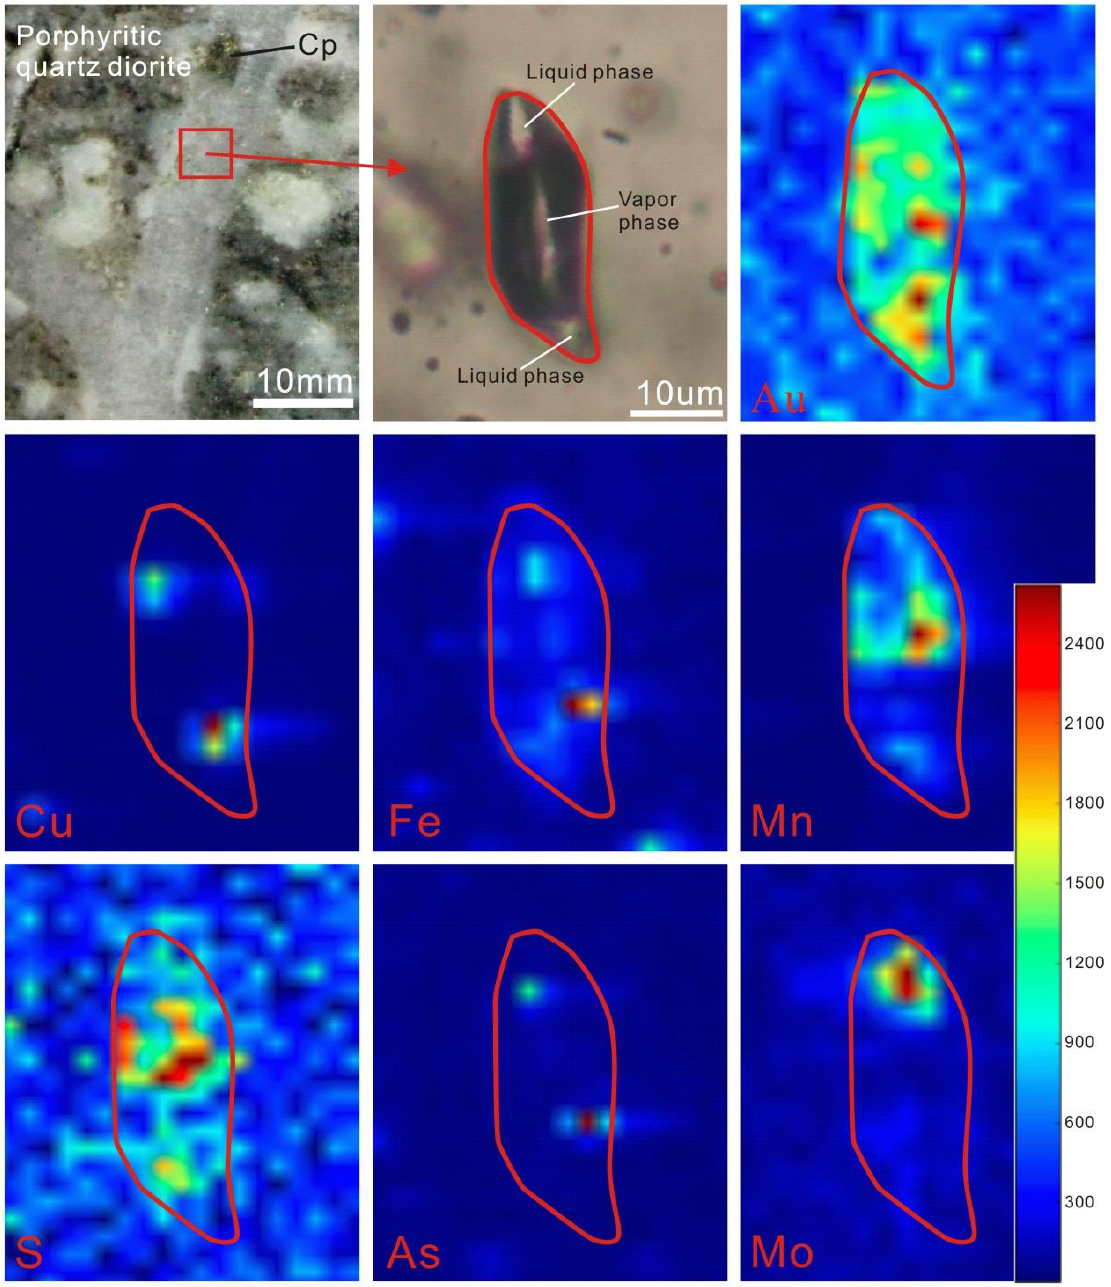
Figure 8. Trace element enrichment maps of a single fluid inclusion in a Cu-bearing vein from the porphyritic quartz diorite.